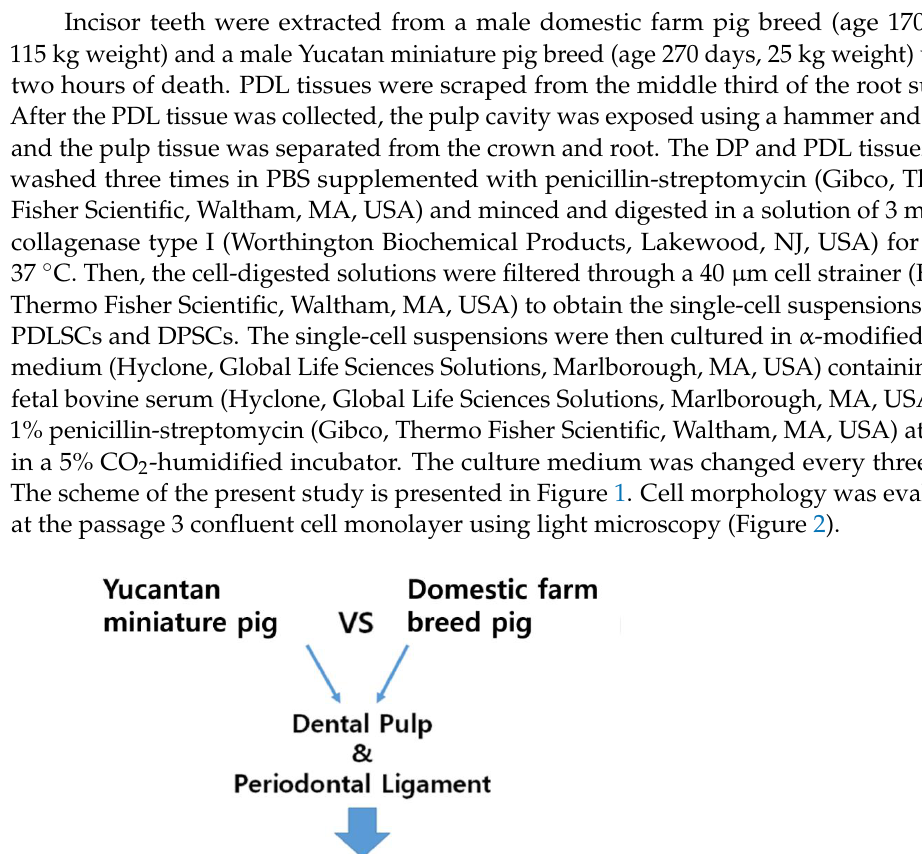
Figure 2. Morphology of the dental pulp stem cells (DPSCs) and periodontal ligament stem cells (PDLSCs) of the miniature pig breed and the domestic farm pig breed at the passage 3 confluent cell monolayer under a light microscope. The passage 3 cells of the DPSCs and PDLSCs of the miniature pig breed and the domestic farm pig breed had a fibroblast-like cell morphology, which is one of the hallmarks of stem cells. 2.2. Fluorescence-Activated Cell Sorting (FACS) Analysis for Cell Surface Markers